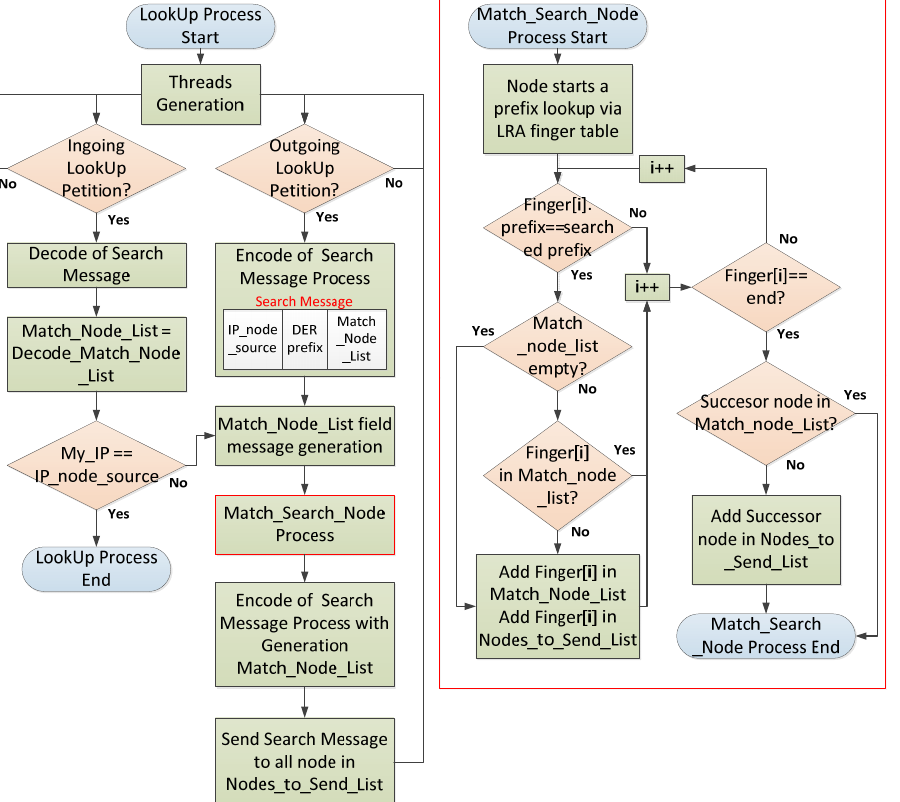
Figure 5. Flowchart of proposed LRA algorithm.